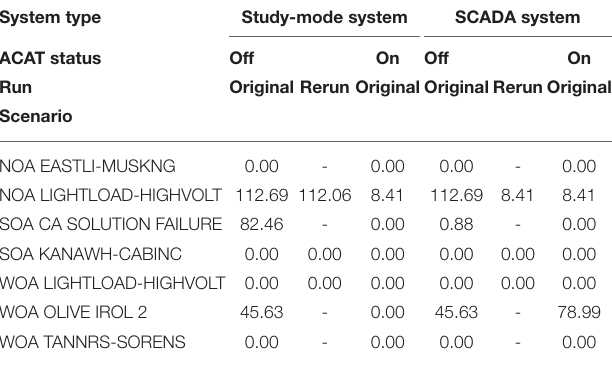
TABLE 7 | System penalties for each scenario.